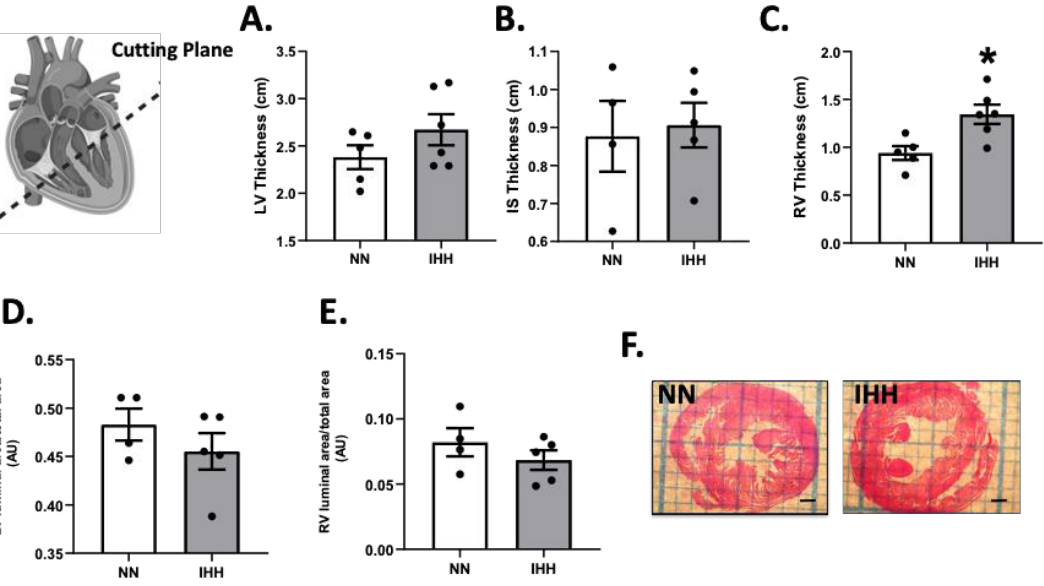
Figure 3. Cardiac morphometry. Left ventricle (LV) thickness ( A ), interventricular septum (IS) thickness ( B ), right ventricle (RV) thickness ( C ), LV luminal area/total area ( D ), and RV luminal area/total ( E ); ( F ) cutting plane depiction. Groups are normobaric normoxia (NN, n = 6) and intermittent hypobaric hypoxia (IHH, n = 6). Data are expressed in mean ± SEM. * statistically significant vs. NN.